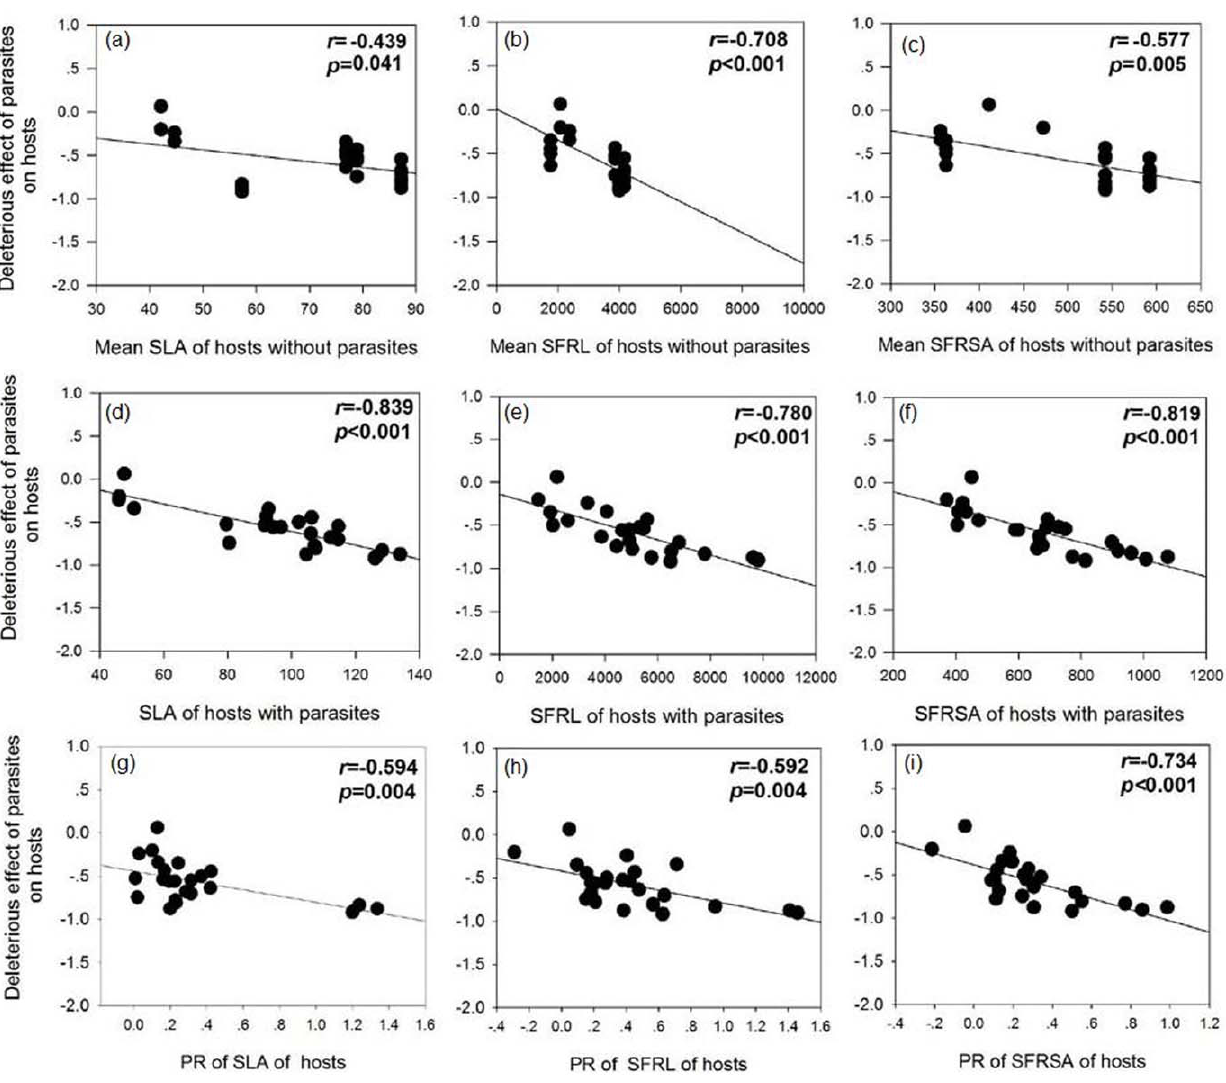
Figure 4. Correlation between the deleterious effect of parasites on hosts and the specific leaf area (SLA) (a), specific fine root length (SFRL) (b) and specific fine root surface area (SFRSA) (c) of hosts without parasites; SLA(d), SFRL(e) and SFRSA(f) of hosts with parasites; parasitism response of SLA(g), SFRL(h) and SFRSA(i) of hosts. Pearson correlation coefficient ( r ) and p -values are given and values in bold are statistically significant at p ,